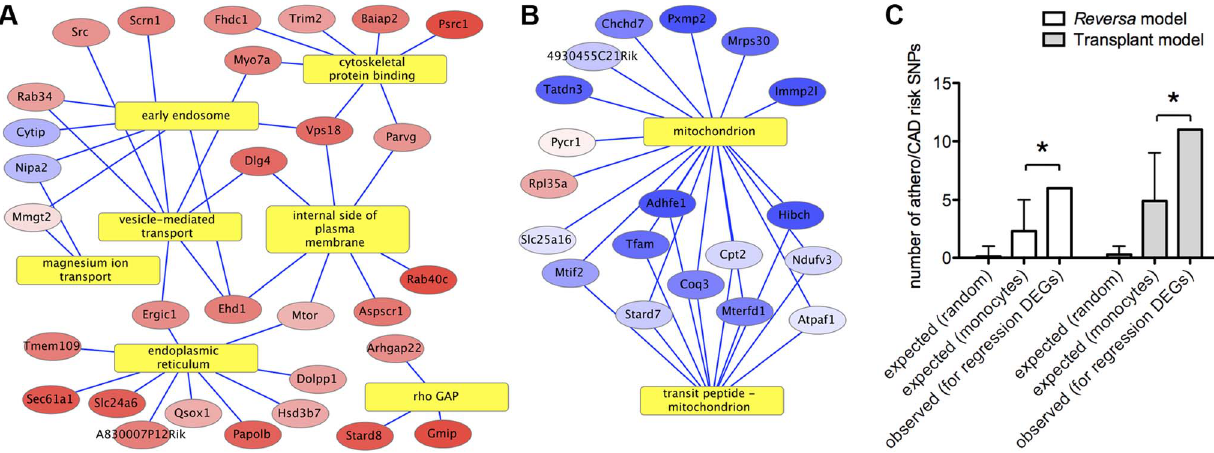
Figure 2. Functional bioinformatic analysis of genes that respond to lipid lowering invivo indicates connections with cell motility and risk of human CAD/atherosclerosis. Yellow rectangles represent gene annotation categories. Ellipses represent genes that are differentially expressed between Mttp -inactivated and vehicle-treated sample groups in plaque macrophages in the Reversa mouse model of plaque regression (red=up in Mttp -inactivated, blue=down). Genes are labeled by official gene symbol. Color saturation indicates the magnitude of the fold-change (see Table S2). Edges connect genes to the statistically enriched annotation categories with which they are associated (see Methods; enrichment P values are given in Table S4). (A) A statistically significant cluster of upregulated genes is associated (by gene annotations) with the cytoskeleton . (B) A statistically significant cluster of downregulated genes is associated with the mitochondrion . (C) Human monocyte expression QTLs for genes that are differentially expressed in plaque CD68 + cells in regression are enriched for SNPs associated with risk of atherosclerosis or CAD, versus the number of atherosclerosis/CAD SNPs for monocyte eQTLs overall . The bars marked ‘‘expected’’ show the range of numbers of SNPs associated with risk of atherosclerosis or CAD that would be expected to occur by chance within the eQTLs of the set of 213 lipid lowering-responsive genes, based on the overall percentage of SNPs that are associated with risk of atherosclerosis/CAD (‘‘random’’) and based on the percentage of SNPs within all monocyte eQTLs that are associated with atherosclerosis/CAD (‘‘monocytes’’). Error bars indicate . 90% confidence intervals for the number of atherosclerosis/ CAD SNPs that would be expected by chance (see Methods). (*) P , 0.05, Fisher’s Exact Test (contingency table data are in Table S6).